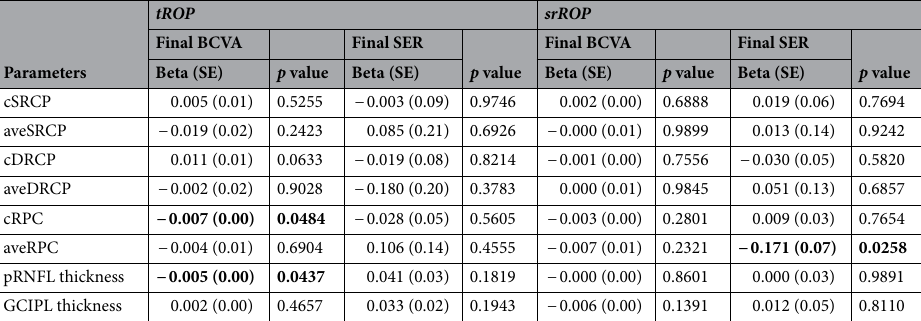
Table 5. Association analysis between foveal, parafoveal and peripapillary vessel density and structural, and visual function outcomes in preterm patients with a history of retinopathy of prematurity with or without treatment. tROP, retinopathy of prematurity with treatment; srROP, spontaneously regressed retinopathy of prematurity; SER, spherical equivalent refractive errors; SE, standard error; BCVA, best corrected visual acuity; pRNFL, peripapillary retinal nerve fiber layer; GCIPL, ganglion cell and inner plexiform layer; SRCP, superficial retinal capillary plexus; DRCP, deep retinal capillary plexus; RPC, radial peripapillary capillary; c, center; ave, average value. p values by linear regression analysis with adjustment for age, birth weight, and gestational age. Boldface indicates statistical significance.